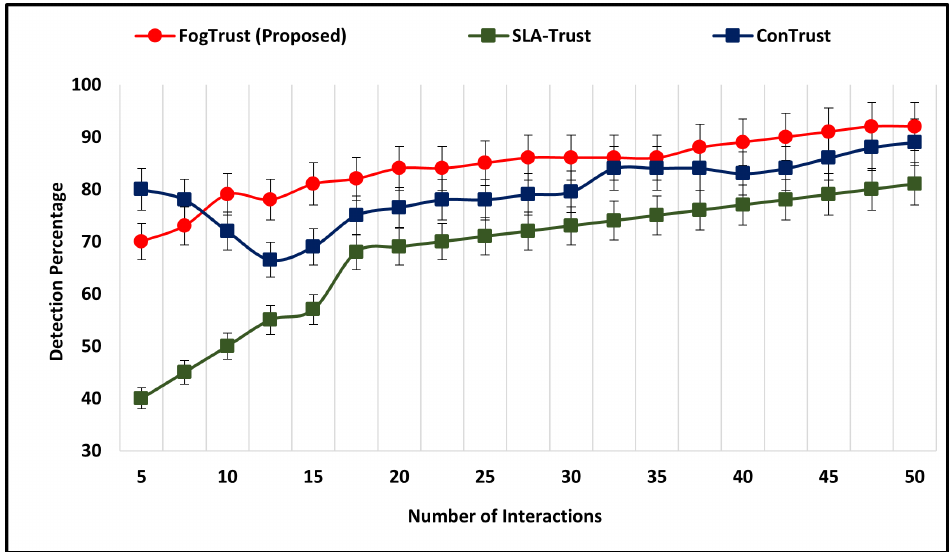
Figure 3. The Detection Rate Comparison of FogTrust with Exiting